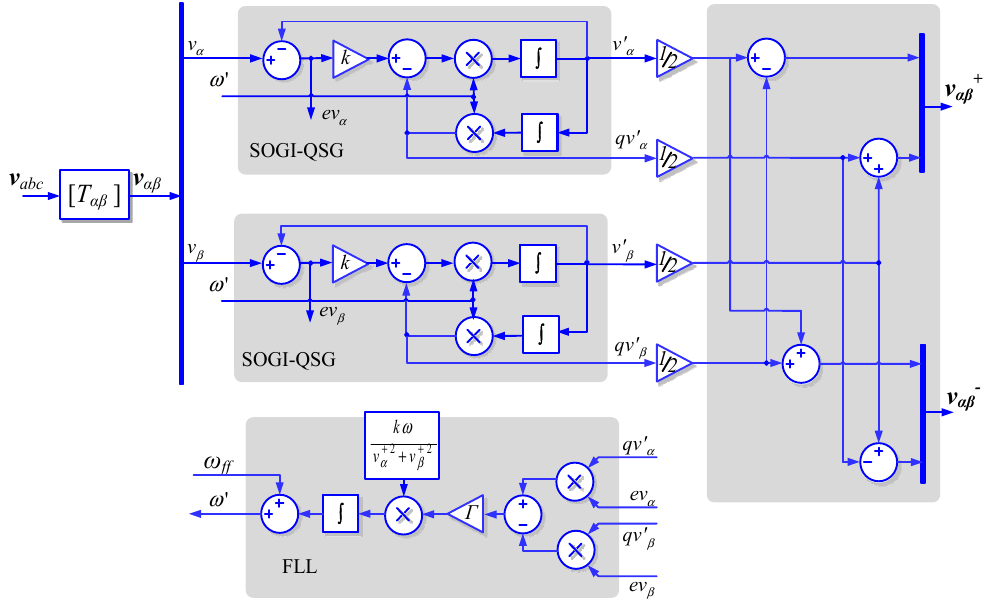
Figure 2. Basic structure of a dual second order generalized integrator-based quadrature signal generator with frequency locked loop and PNSC.